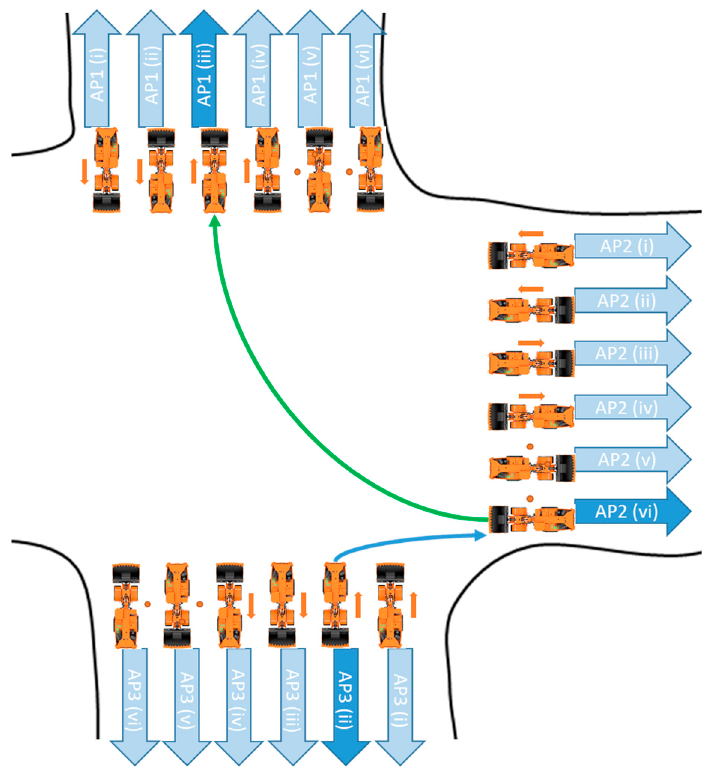
Figure 8. Representation of an inversion maneuver in the TMM.